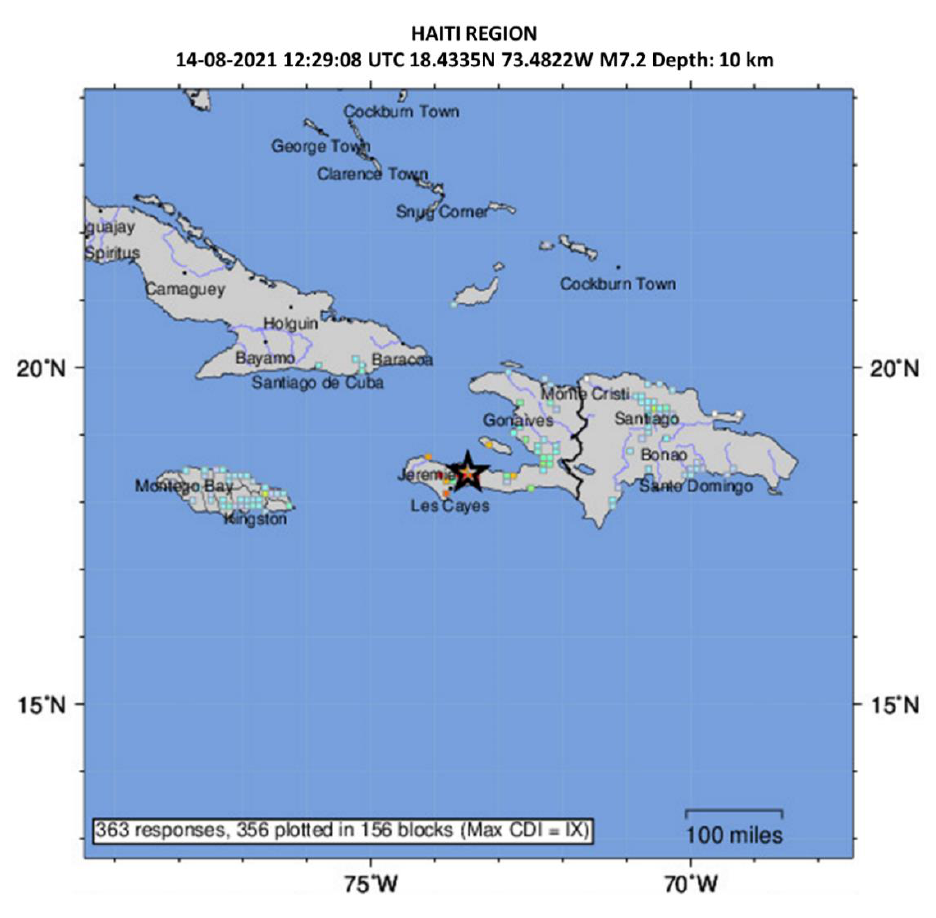
Figure 1. USGS Community Internet Intensity Map